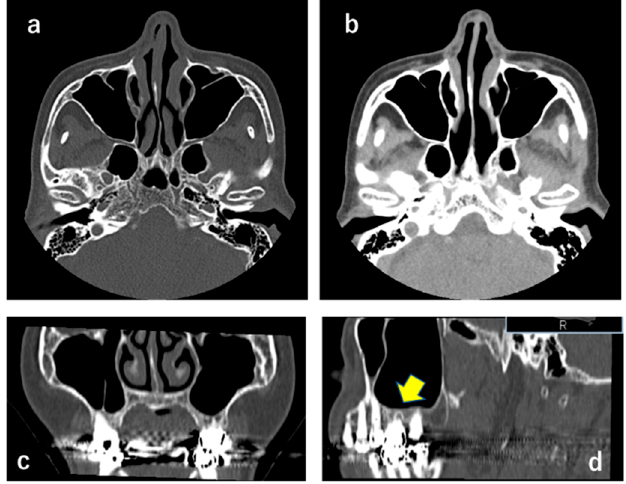
Figure 2. CT X-ray showing that masses were not observed in the left maxillary sinus ( a – c ). ( b ) indicates soft tissue density. A sagittal section (( d ); yellow arrow) shows an apical periodontitis-like image at the maxillary left first molar, suggesting that this was not relevant to the clinical findings.